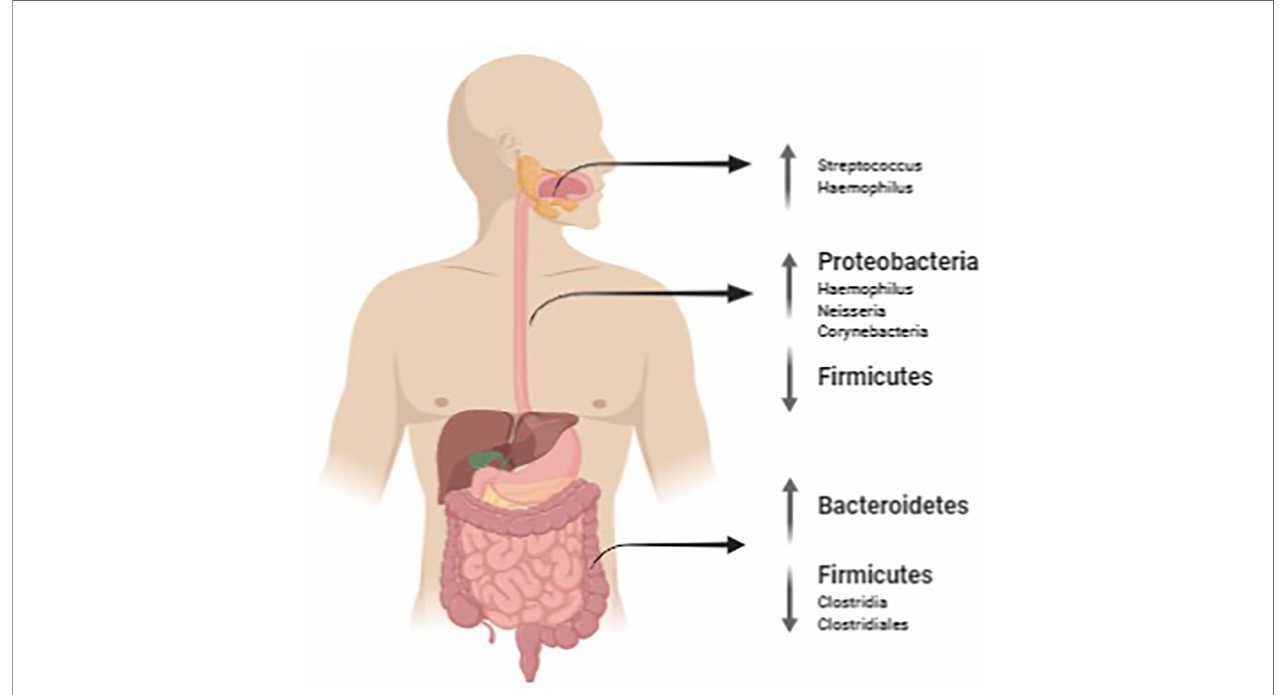
FIGURE 1 | Salivary, oesophageal and gut microbiota mutations in EoE. The image was created with